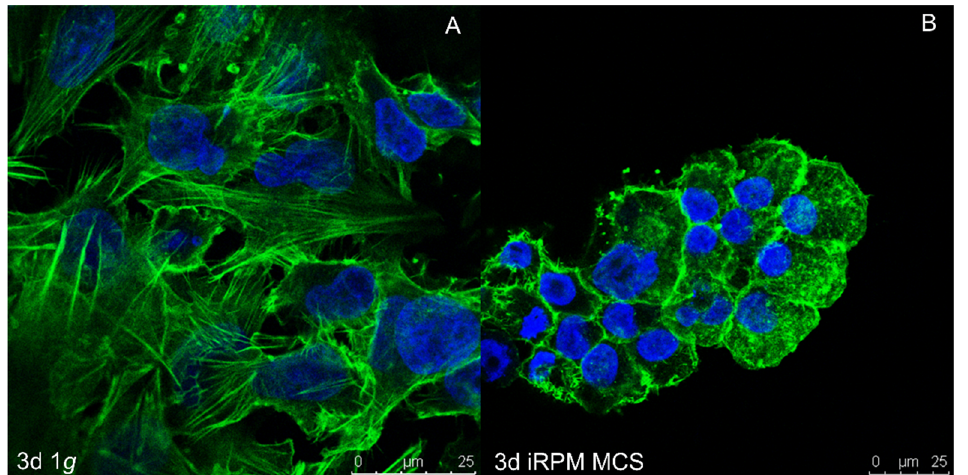
Figure 3. F-actin cytoskeleton: ( A ) Lung cancer cells cultured under static 1 g conditions stained with DAPI (blue nuclei) and labeling of F-actin with phalloidin (green colored cytoskeleton) and ( B ) MCS of LCC cultured in the iRPM.